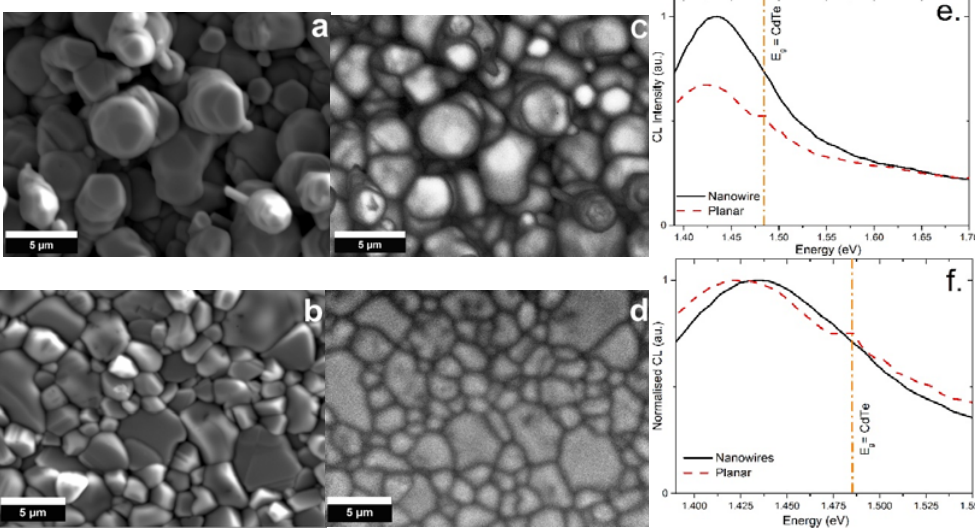
Figure 5. SEM images for CdTe wires ( a ) and the planar ( b ) CdTe film; along with CL images for the wires ( c ) and planar film ( d ). Normalized CL spectra produced for the CdTe wires and CdTe planar film ( e , f ). CdTe samples were grown at vacuum. ( e ) Has been normalized with respect to the highest signal, therefore the wire signal was set to 1. In order for the peak shift to be directly analyzed the signals were both normalized to 1 so that the intensities of the signals was neglected ( f ).